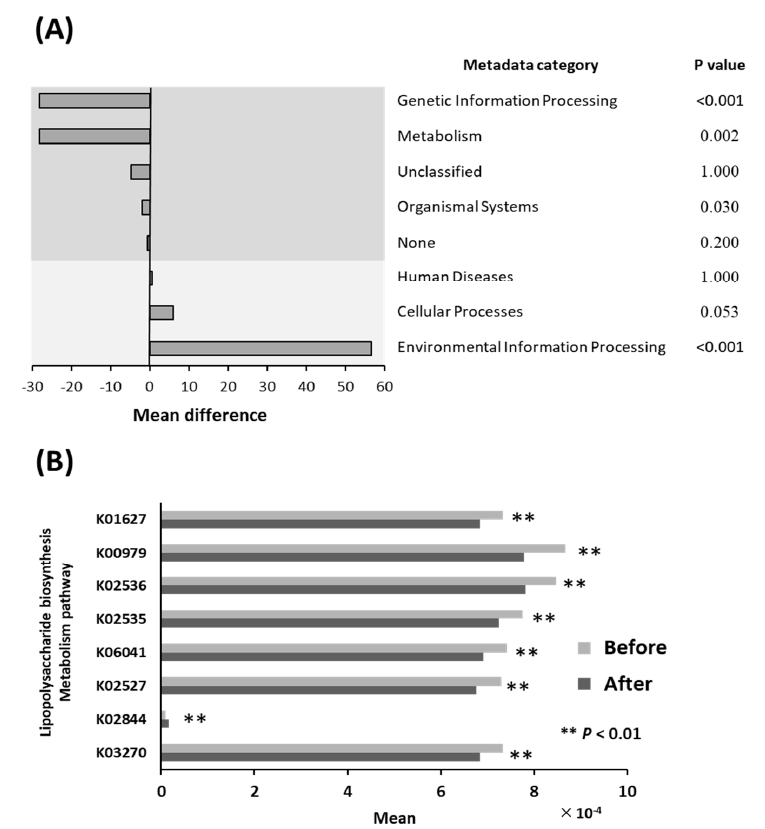
Figure 3. ( A ) Changes in the relative abundances of functional bacterial pathways in the E group. Po- tential differences (original value × 10 − 4 ) in microbiome functions were evaluated using PICRUSt